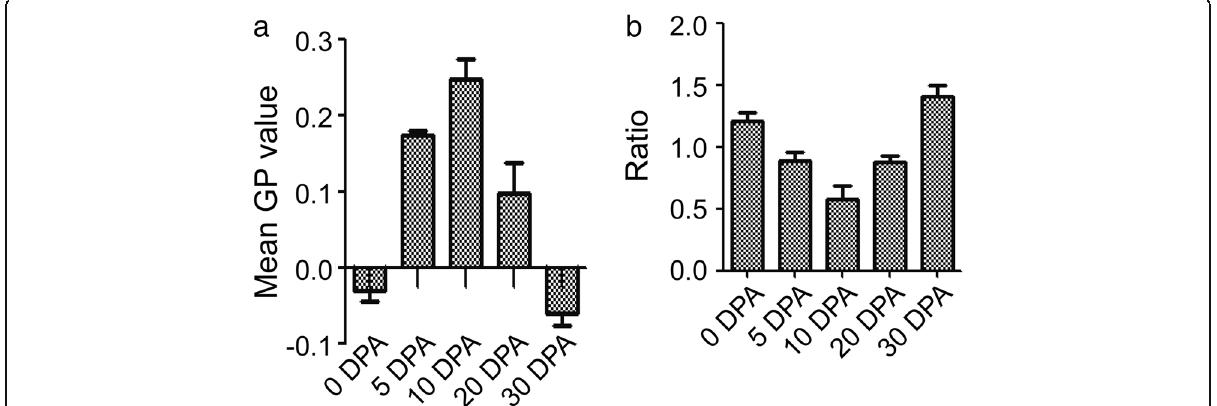
Fig. 5 The GP and Ratio value of wild-type cotton fiber. a The GP value of 0 DPA, 5 DPA, 10 DPA, 20 DPA, and 30 DPA wild-type cotton fibers. b The Ratio r/g value statistics of 0 DPA, 5 DPA, 10 DPA, 20 DPA, 30 DPA wild-type cotton